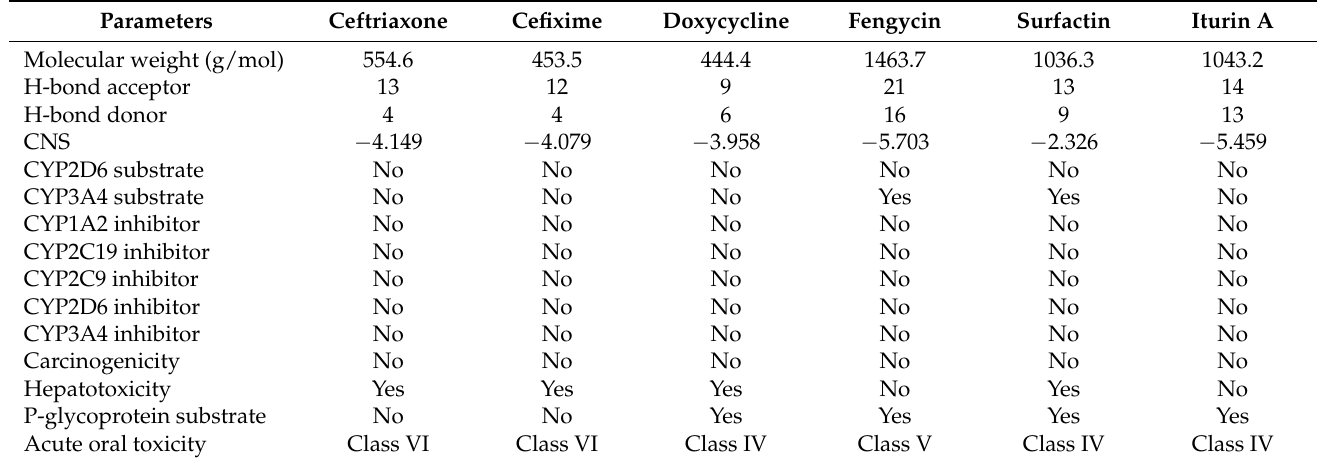
Table 8. ADMET analysis of each